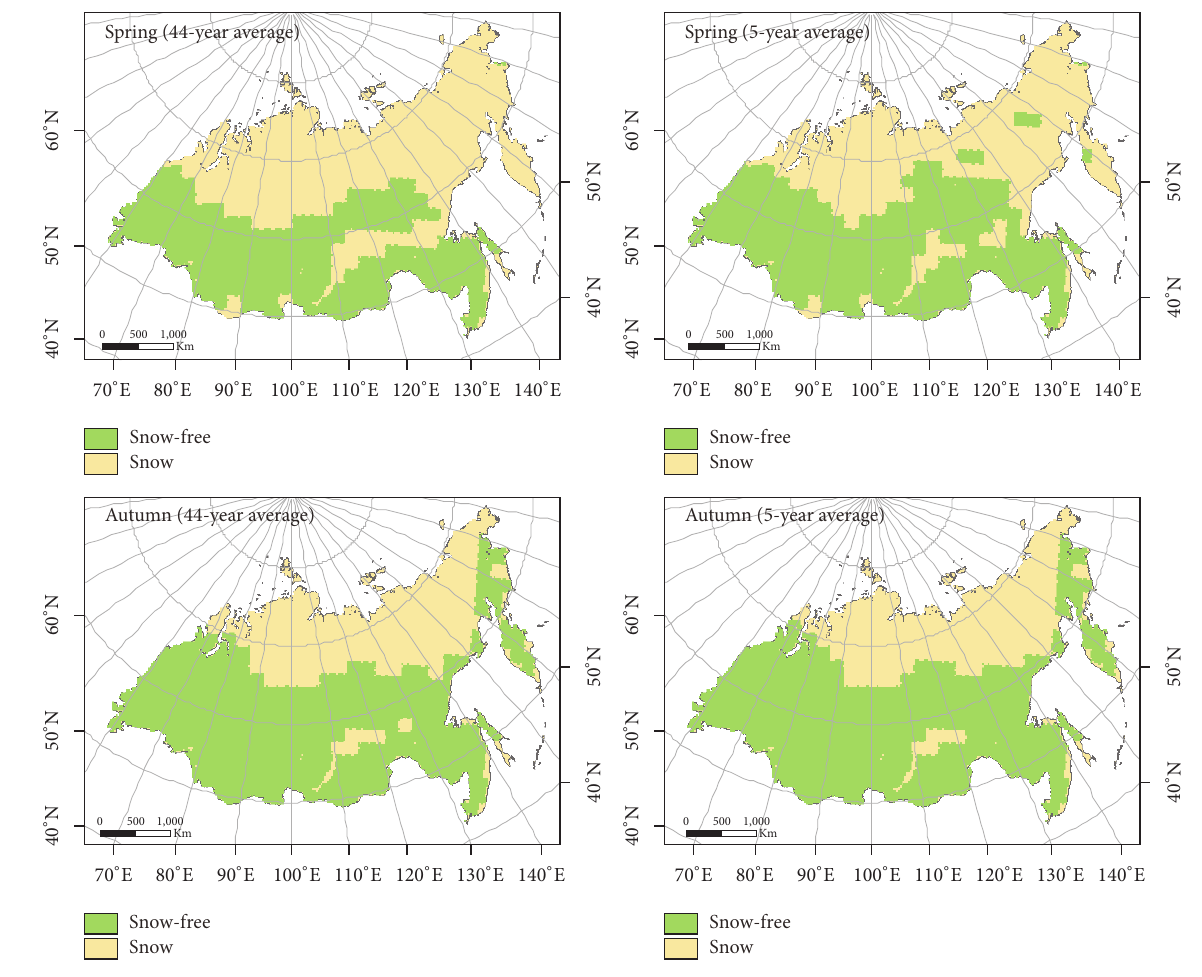
Figure 3: The average snow cover extent in spring and autumn from 1970 to 2013 and from 2009 to 2013.